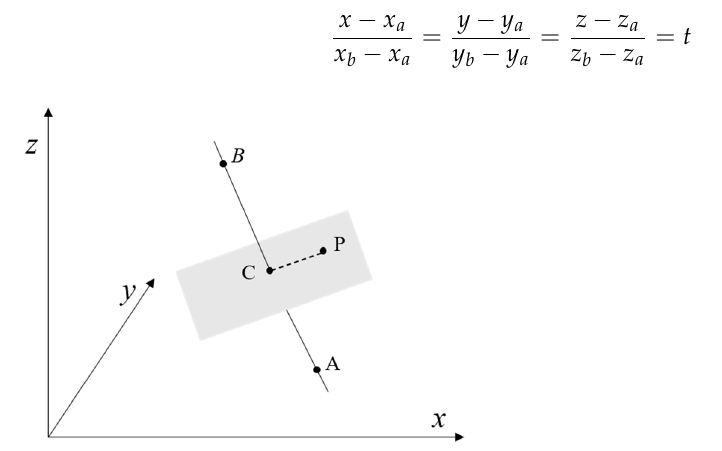
Figure 6. A demonstration of RANSAC for space line detection.